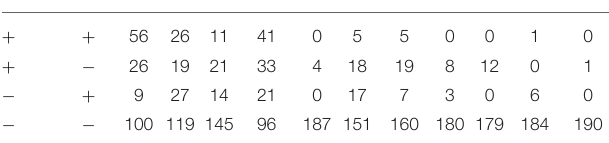
TABLE 3 | Summary of the health condition diagnoses when using the results from majority-rule of three digital